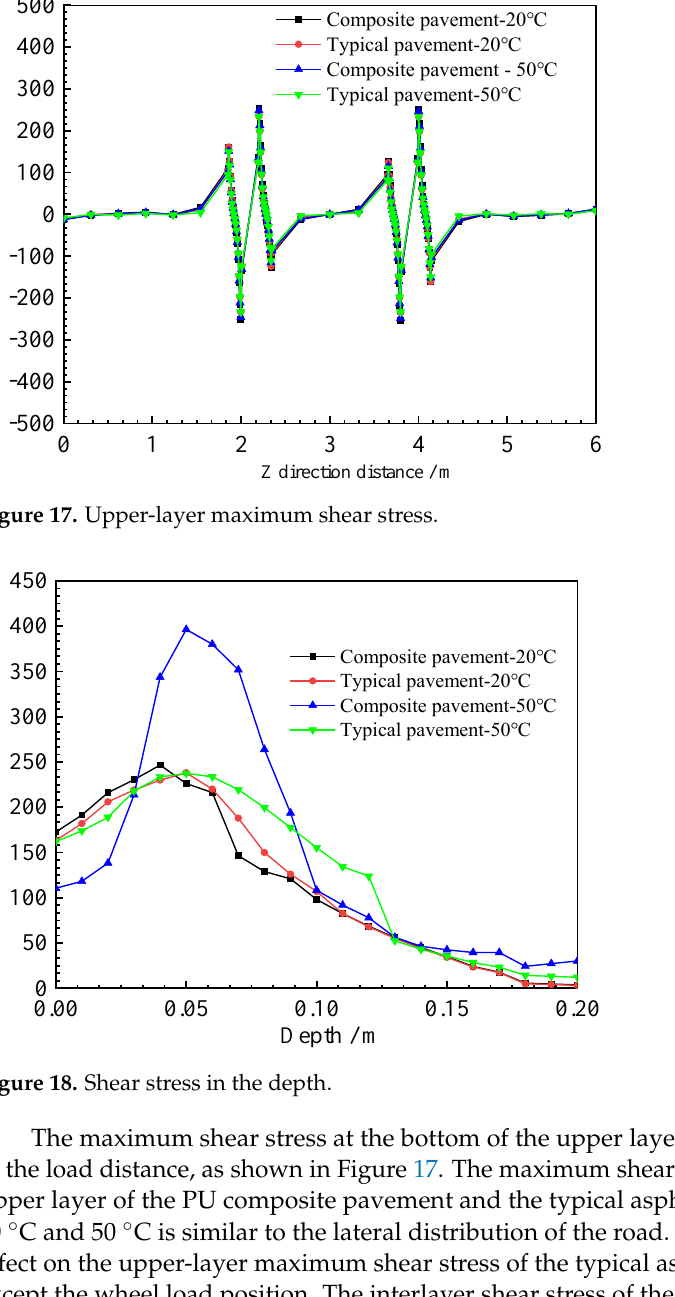
The upper-layer bottom shear stress and the maximum shear stress in the depth direction of the two pavement structures are shown in Figures 17 and 18.